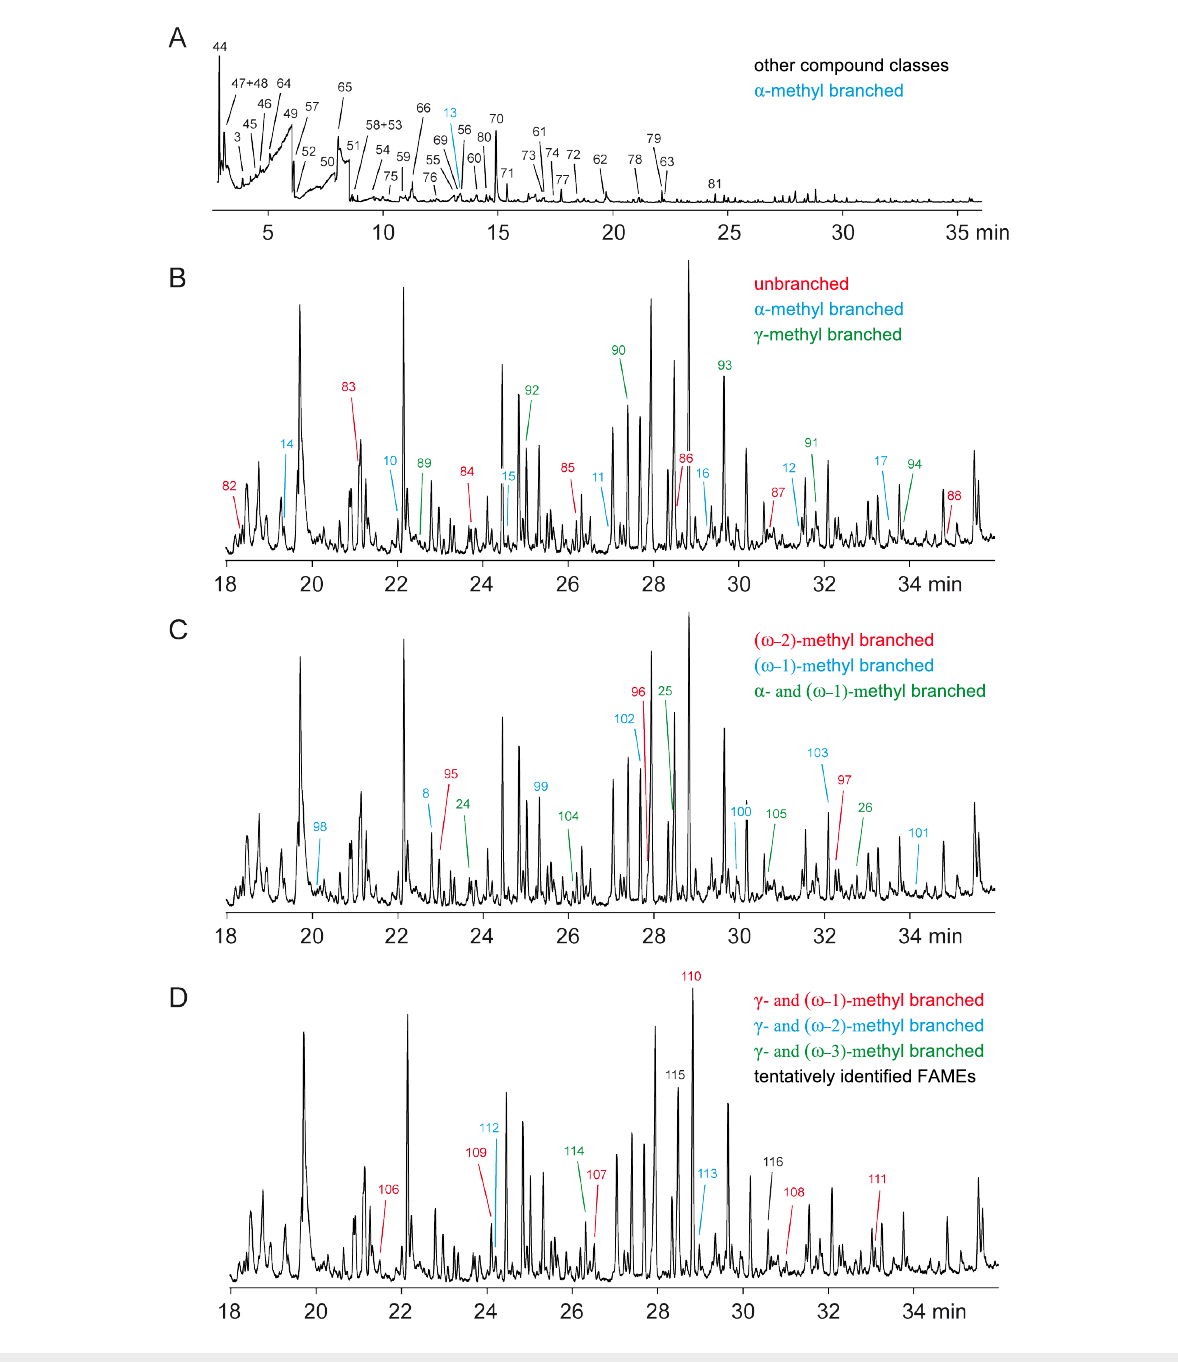
Figure 3: Total ion chromatograms of the headspace extract from M. aurantiaca (A), and expansions of the total ion chromatogram (18–36 min) showing the relevant peaks of the FAMEs (B–D, for clarity the same expansion is shown in three replicates for FAMEs from different series). The colour code used for these series of FAMEs is given in the respective